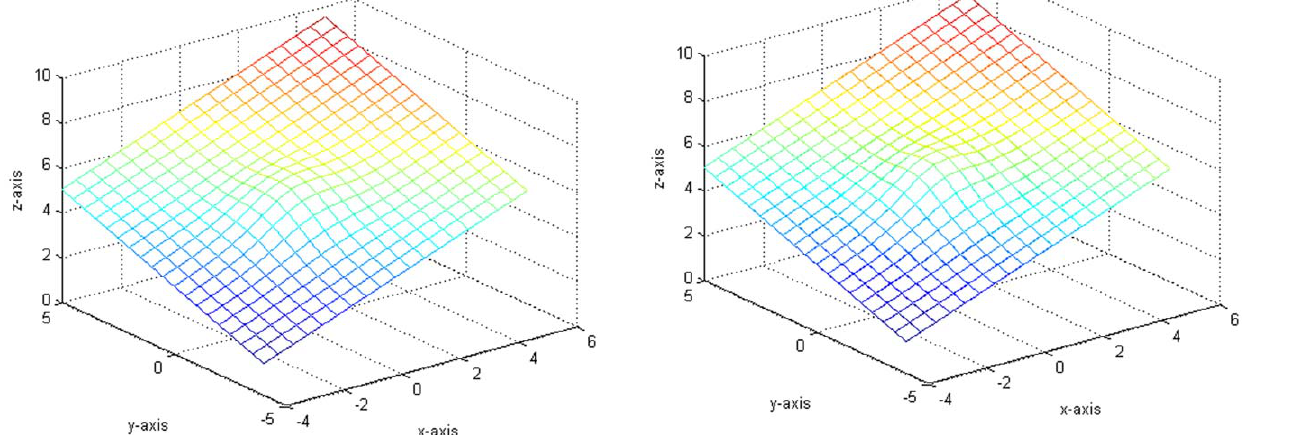
Figure 16. The fitted plot after 10000 replicates.